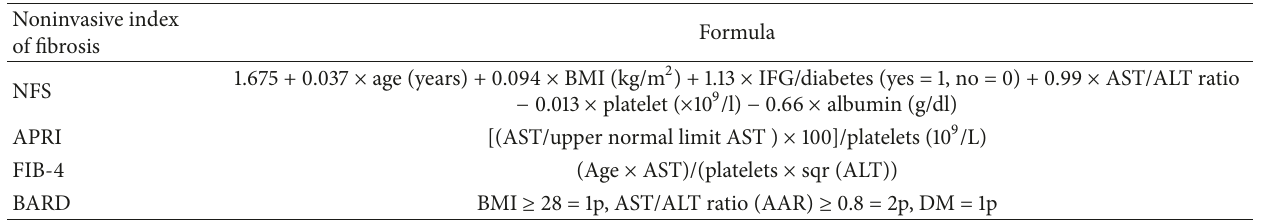
Table 2: Formulas for calculating noninvasive scores for fibrosis [12, 13].